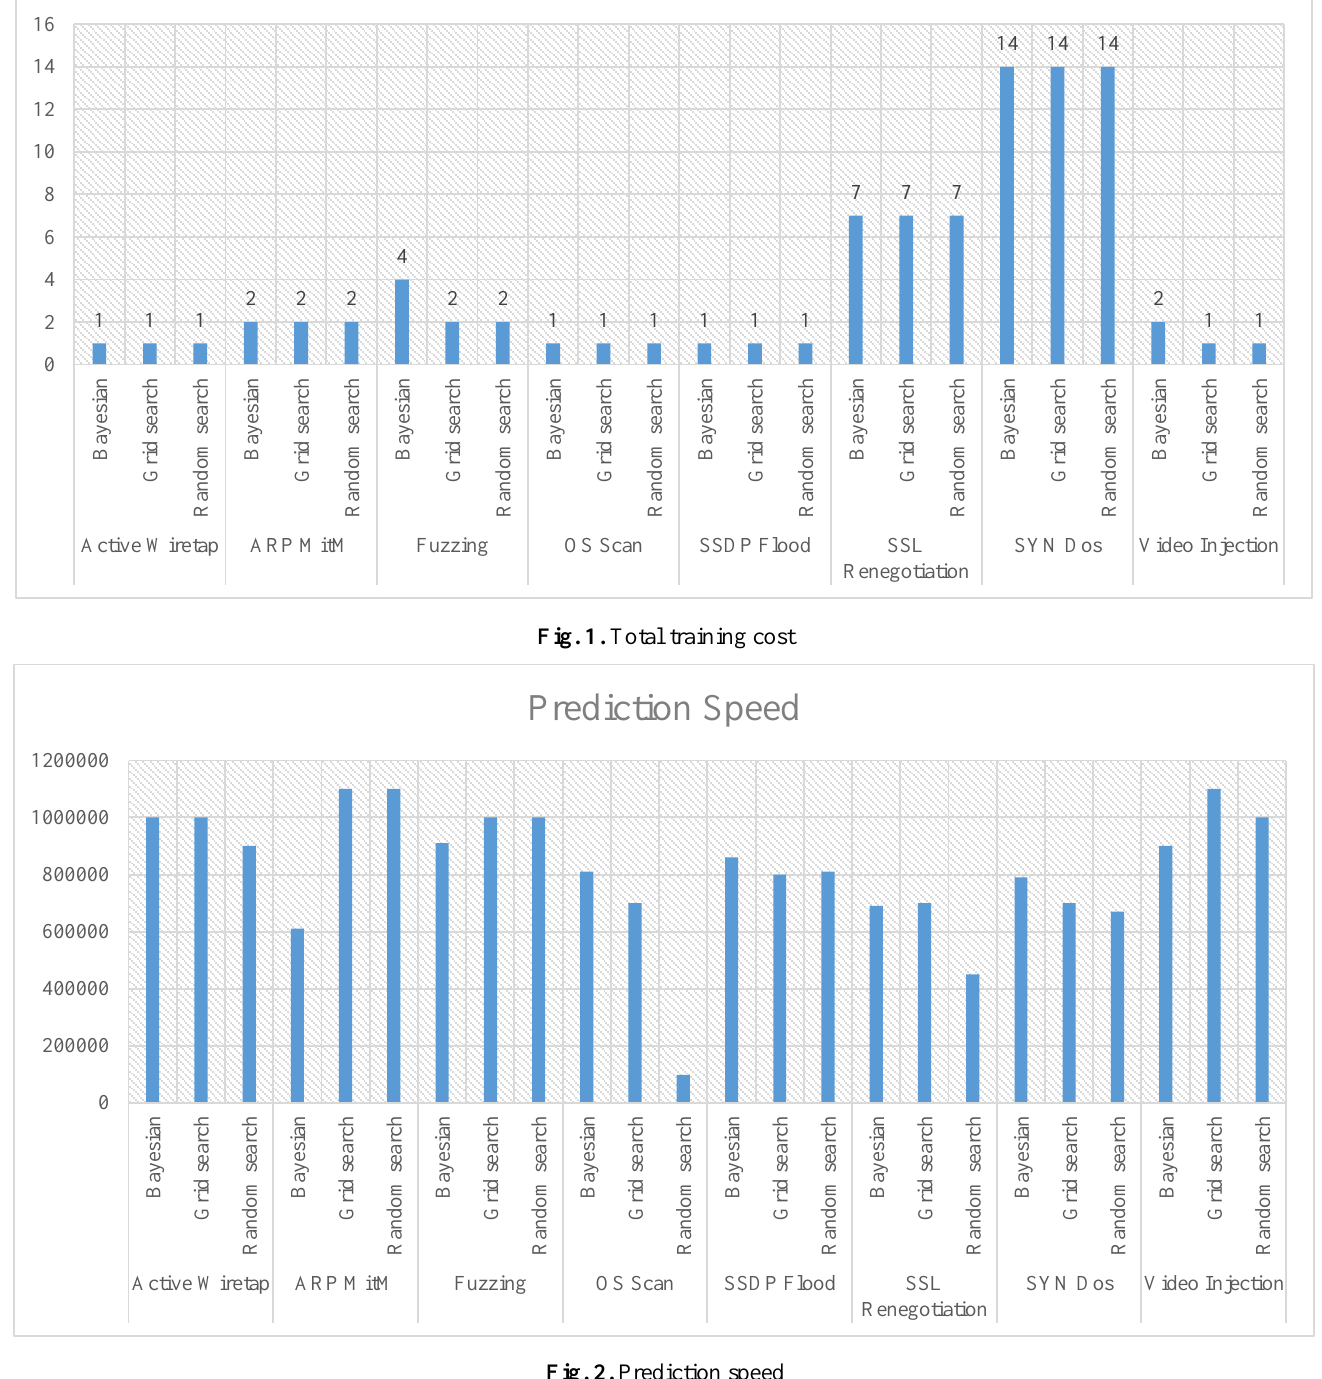
Fig. 2. Prediction